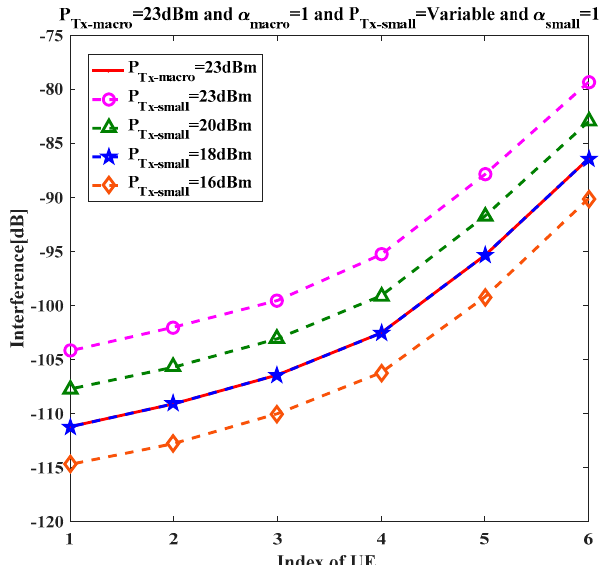
Figure8. Interferencecomparisonasafunctionof P max Figure 8. Interference comparison as a function of P max in the uniform macro and small cell deployments.